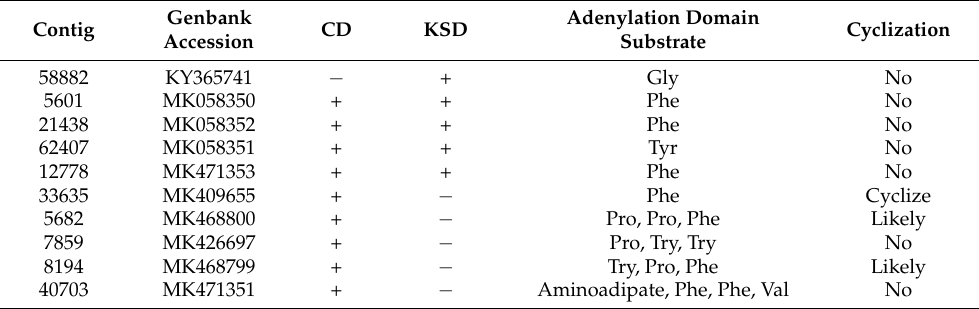
Table 2. SeMPI, antiSMASH, NaPDoS, NRPSep, and IntrProScan predictions for Alternaria oxytropis PKS and NRPS domains. The predictions show the presence or absence of condensation domain (CD), and ketosynthase domain (KSD); the predicted substrates for the adenylation domain; and the enzymatic cyclization of the final